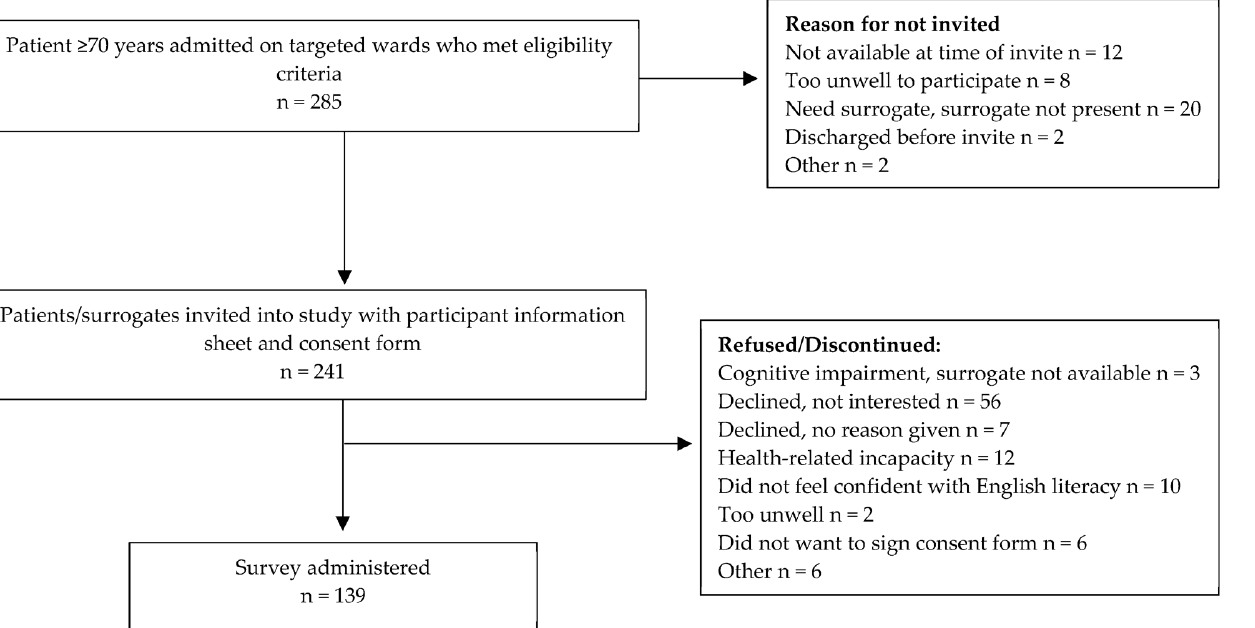
Figure 1. Flow chart of the recruitment procedure. Table 1. Participant characteristics (N = 139) .